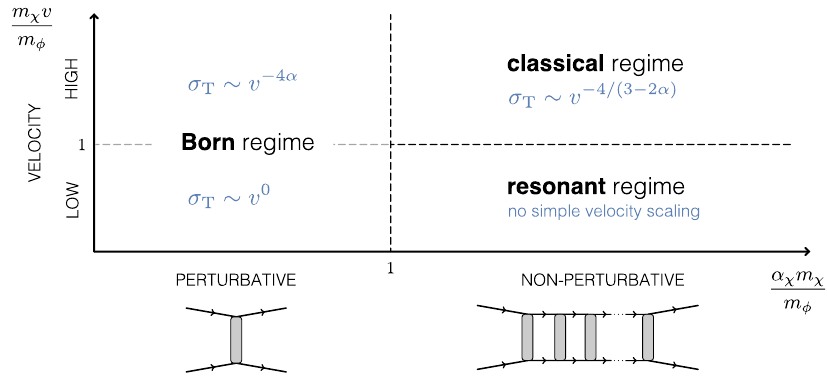
Figure 3 . Regimes of self-interacting dark matter. The horizontal axis measures whether the ladder of mediator exchanges can be approximated by a single mediator exchange. The vertical axis is a measure of the velocity. The figures of merit are scaled by the ratio of the dark matter mass to the mediator mass (or mass gap) so that the regimes are limits relative to unity. The perturbative regime is described by the Born approximation over the range of all velocities, whereas the non- perturbative regime is separated into a classical regime at high velocities and a resonant regime at low velocities. Blue: asymptotic velocity scaling of the transfer cross section σ T in the continuum- mediated scenario. No simple scaling exists in the resonant regime. The standard case of a single 4D mediator corresponds to α = 1